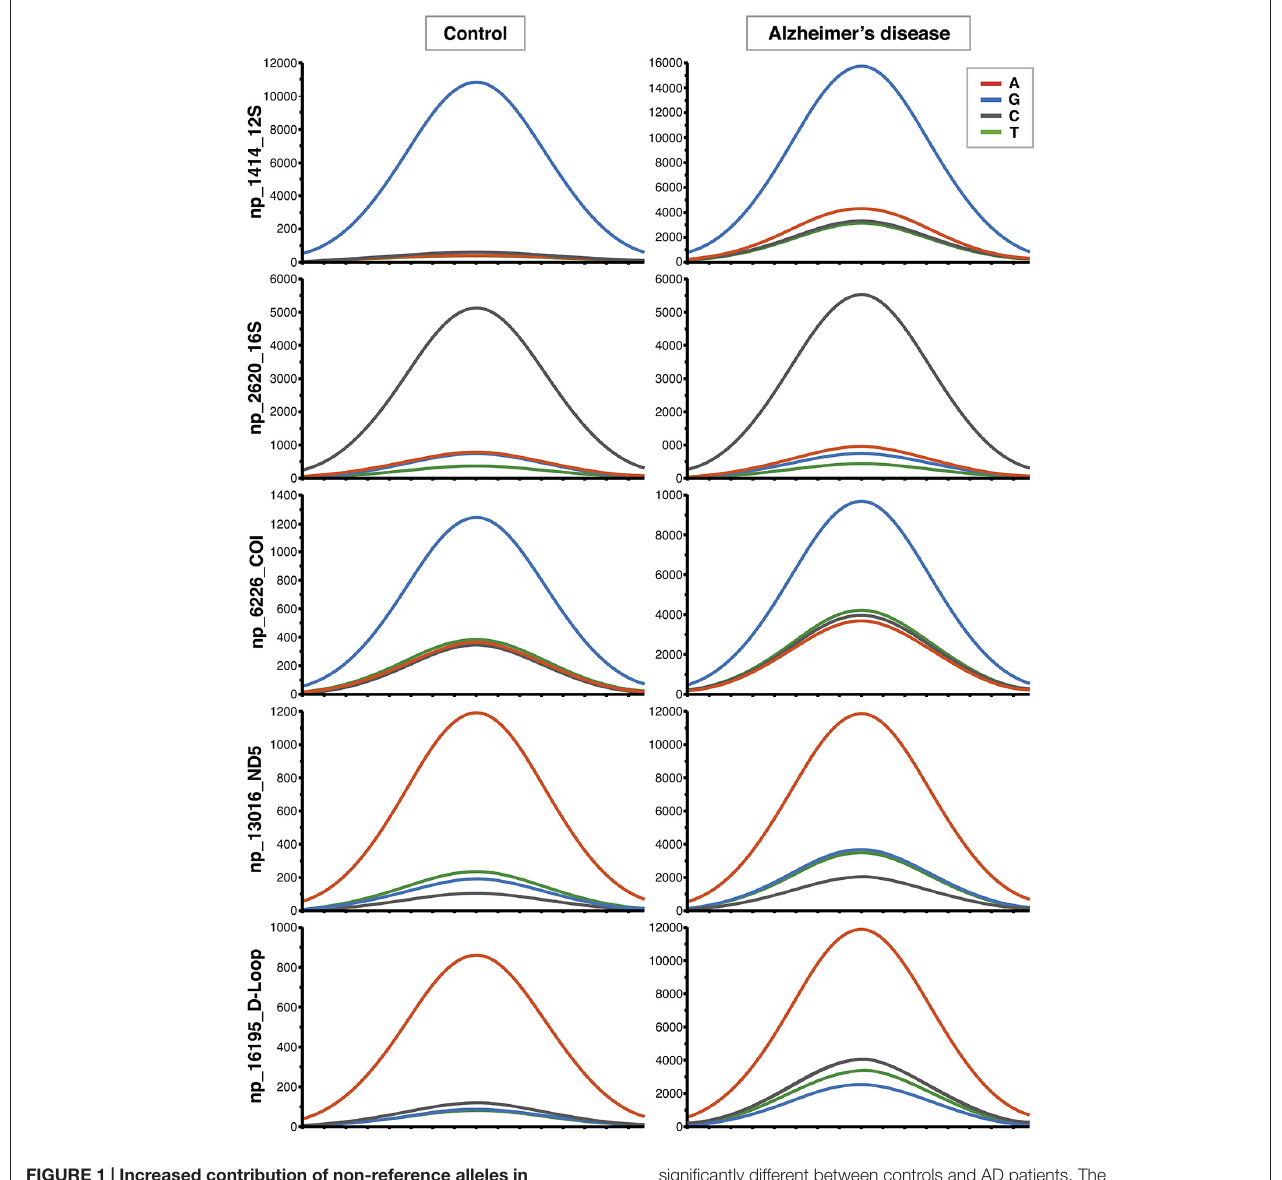
FIGURE 1 | Increased contribution of non-reference alleles in mitochondrial DNA (mtDNA) of Alzheimer’s disease (AD) subjects. Representative Affymetrix sequencing chromatograms (forward strand) relating to 5 of the 270 nucleotide positions (nps)